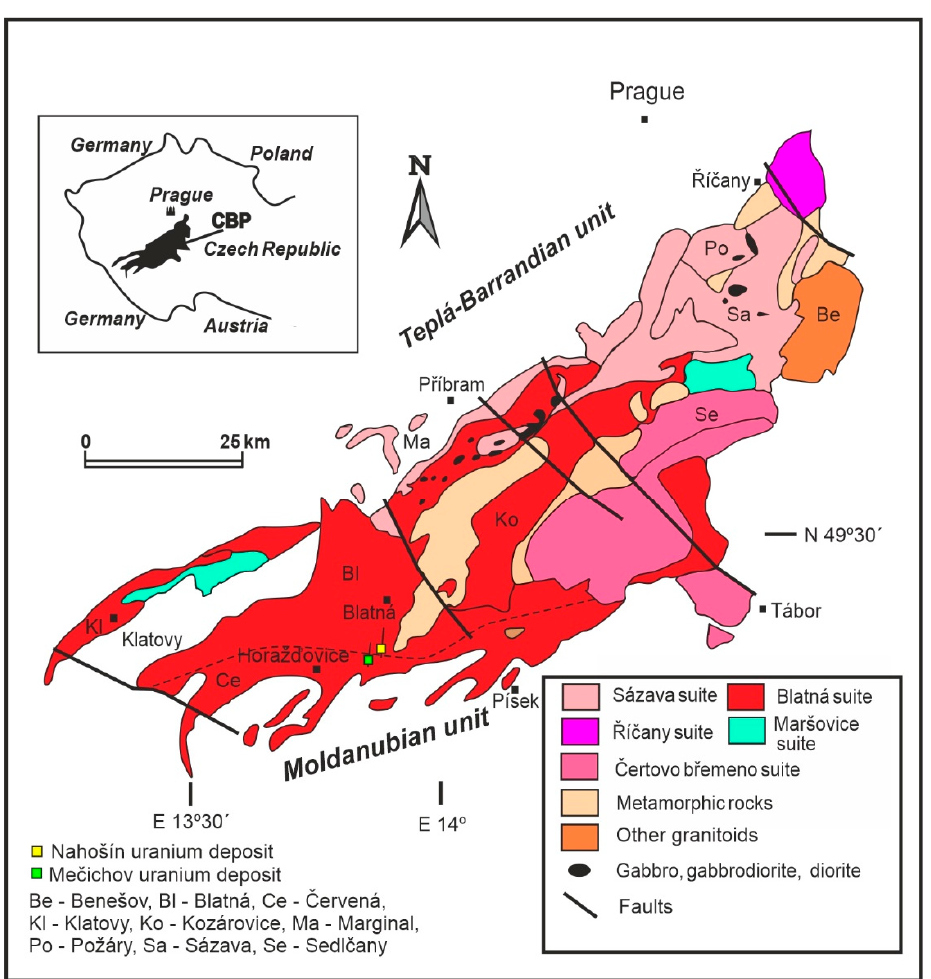
Figure 1. Geologic map of the Central Bohemian plutonic complex, modified from [13].